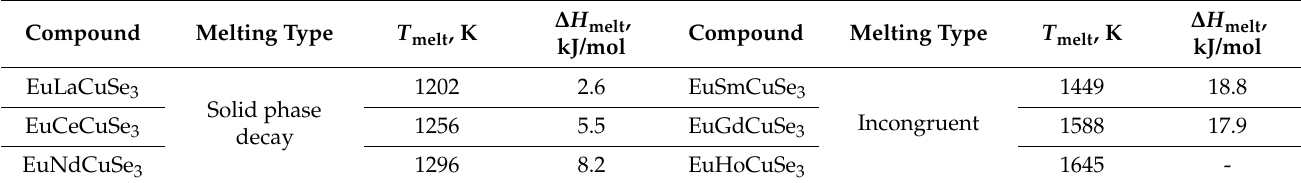
Table 5. Temperatures and enthalpies of melting of EuLnCuSe 3